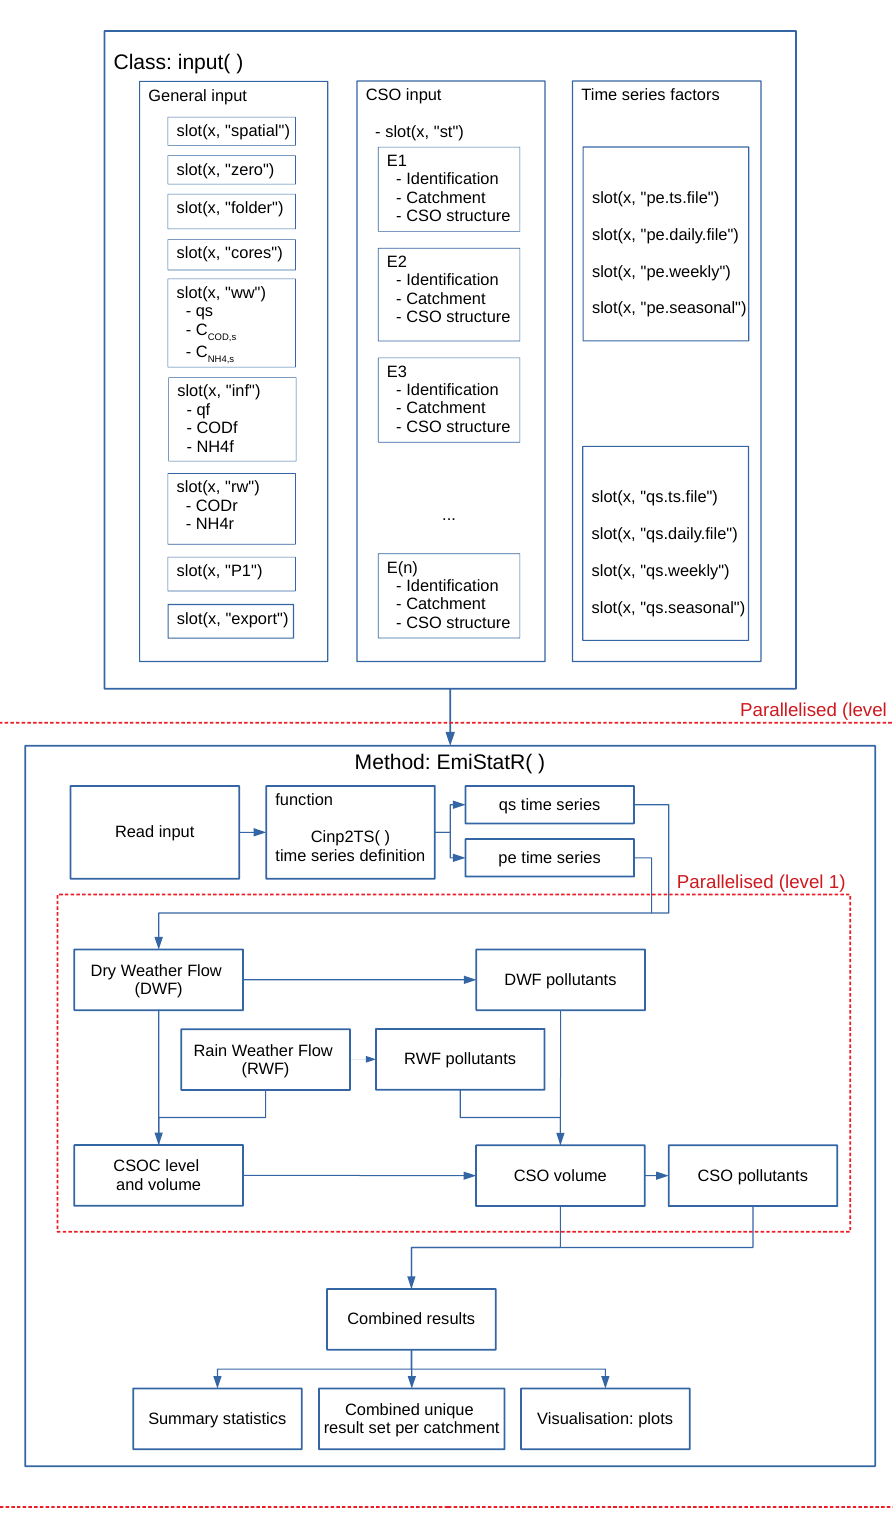
Figure 2. Workflow for EmiStatR and the parallelised approach. Parallelisation is set in the input() class, slot(x, “cores”). Level 1: Parallel computing is done inside EmiStatR. Level 2: Parallel computing is done outside of EmiStatR, e.g., Monte Carlo simulation or